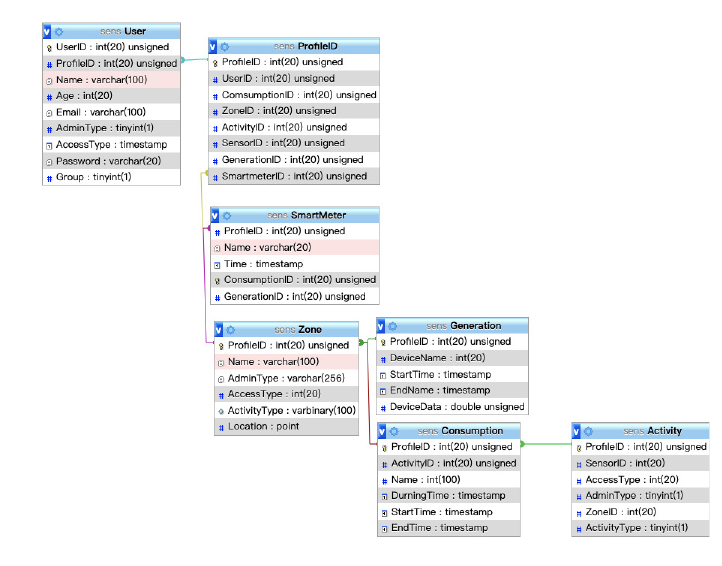
Figure 6. SENS brevity/readability UML diagram.